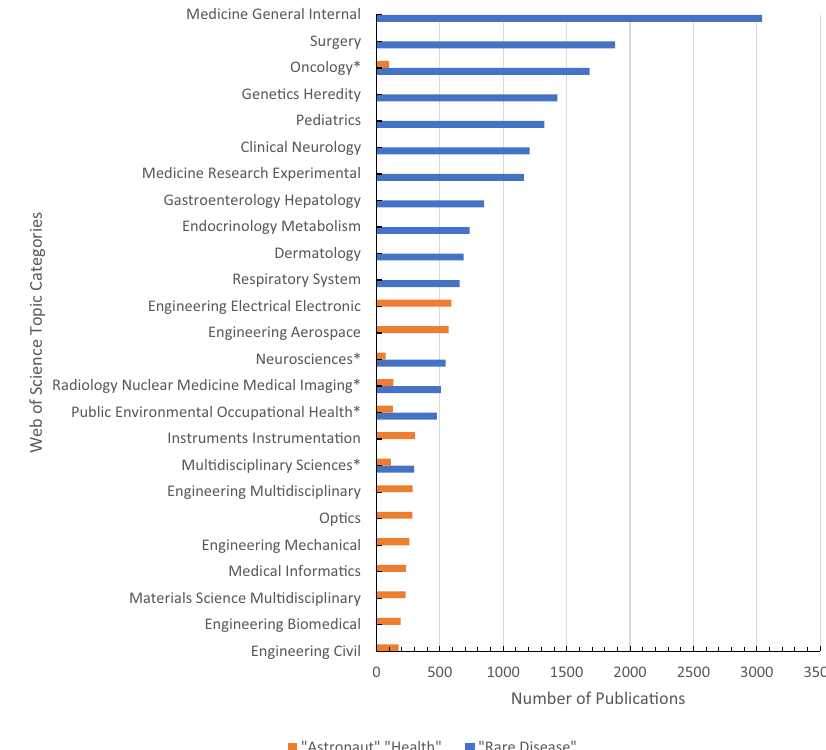
Fig. 2 Number of publications for rare diseases and space health as a function of topic categories. Despite a common focus on health, the fi elds of rare diseases and space health have little overlap in terms of dominant research topics. Space health appears to be technology or engineering oriented, while rare disease integrates a more medical focus. The top 26 most common research categories based on number of publications were generated from Web of Science for the keyword ’ s “ astronaut ” + “ health ” and “ rare disease ” . The top 10 categories based on publications were graphed for both “ astronaut health ” and “ rare disease ” . Five out of 52 total research topics found in common between both keywords were also graphed and denoted with * (Multidisciplinary Sciences, Oncology, Neurosciences Public Environmental Occupation, and Radiology Nuclear Medicine). Data in Source data